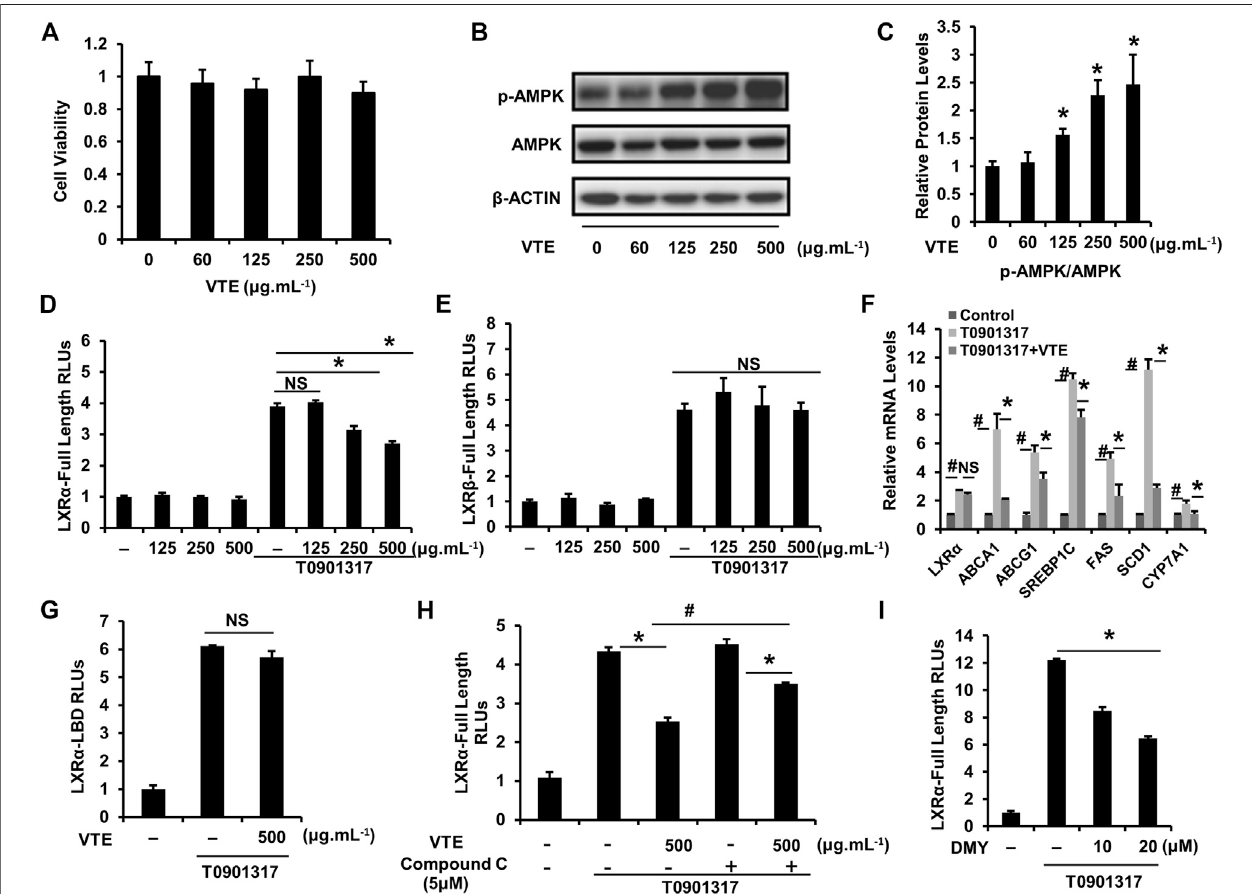
FIGURE7| VTEstimulatesintracellularAMPK-LXR α signaling (A) TheMTTassayinHepG2cell.HepG2cellsweretreatedwithDMSOcontrolandVTE(0,60,125, 250,and500 μ g ml − 1 )for24 handcytotoxicitywasassessedbyMTT.Dataarestatisticallyanalysedasmeans ± SEM( n (cid:2) 5) (B,C) Proteinlevelsofp-AMPKandAMPK in HepG2 cells were analysed by immunoblotting. The relative protein level was shown. AMPK was used as a control for protein levels. (D, E) LXR α , ß transcriptional activities were analysed using transient transfection reporter assays. HepG2 cells were co-transfected with pCMX-hLXR α , ß and the LXRE reporter vector for 24 h and treated with control (0.1% DMSO), VTE (125, 250, and 500 μ g ml − 1 ), T0901317 (5 μ M) for another 24 h. The relative luciferase units (RLUs) were measured by comparison with renilla luciferase activities (F) The relative mRNA levels of LXR α and its targets in VTE-treated and con (0.1% DMSO) HepG2 cells. HepG2 cells were incubated with VTE (500 μ g ml − 1 ) or/and T0901317 (2 μ M) for 24 h β -ACTIN was used as an internal control for normalizing the mRNA levels (G) HepG2 cells were co- transfected with pCMXGal-hLXR α -LBD and MH100 × 4-TK-Luc for 24 h and treated with control (0.1% DMSO), VTE (500 μ g ml − 1 ), T0901317 (5 μ M) for another 24 h. Therelativeluciferaseunits(RLUs)weremeasuredbycomparisonwithrenillaluciferaseactivities (H,I) HepG2cellswereco-transfectedwithpCMX-hLXR α andtheLXRE reportervectorfor24 handtreatedwithcontrol(0.1%DMSO),VTE(500 μ g ml − 1 ),T0901317(5 μ M)CompoundC(5 μ M)andDMY(10and20 μ M)foranother24 h.The relative luciferase units (RLUs) were measured by comparison to renilla luciferase activities. The results represent three independent experiments, and data are statistically analysed as means ± SEM ( n (cid:2) 3). * p < 0.05, control versus VTE group, T0901317 versus T0901317 + VTE group, T0901317 + Compound C + VTE versus T0901317+CompoundCgroup,orT0901317versusT0901317+DMYgroup. # p < 0.05,T0901317comparedwiththecontrolgroup,orT0901317 +VTEcompared with the T0901317 + Compound C + VTE group. NS, no signi fi